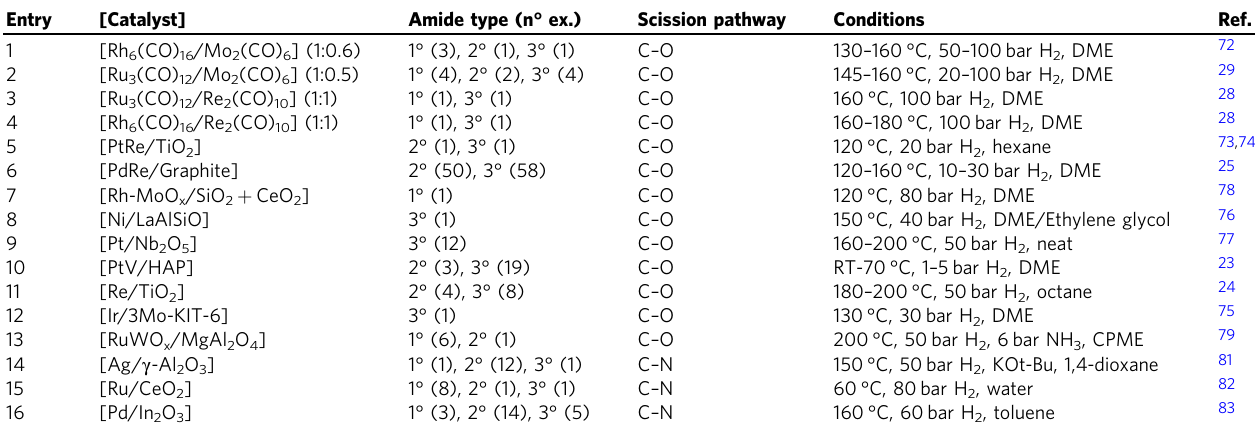
Table 1 Heterogeneous catalytic hydrogenations of amides developed over the last